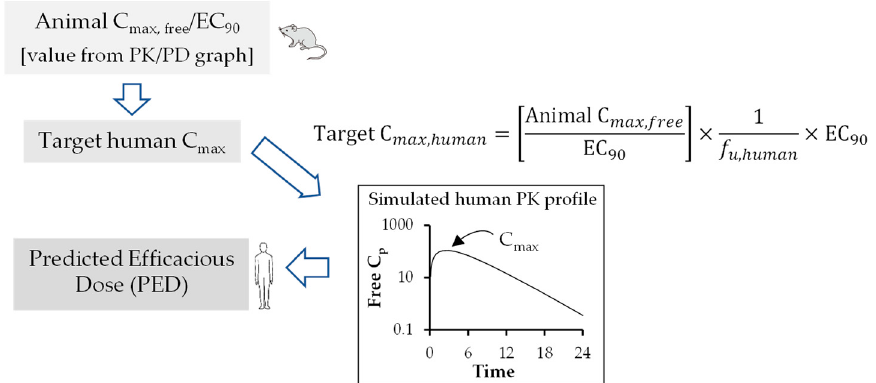
Figure 4. Flow chart for prediction of human efficacious dose using animal C max,free /EC 90. Animal C max,free /EC 90 value is estimated from PK/PD graph. Target human C max is calculated from the above mathematical expression. The human PED is estimated from the simulated free Cp versus time curve. The dose at which the Cmax of the simulated free Cp versus time curve coincides with Target human Cmax is the human PED.